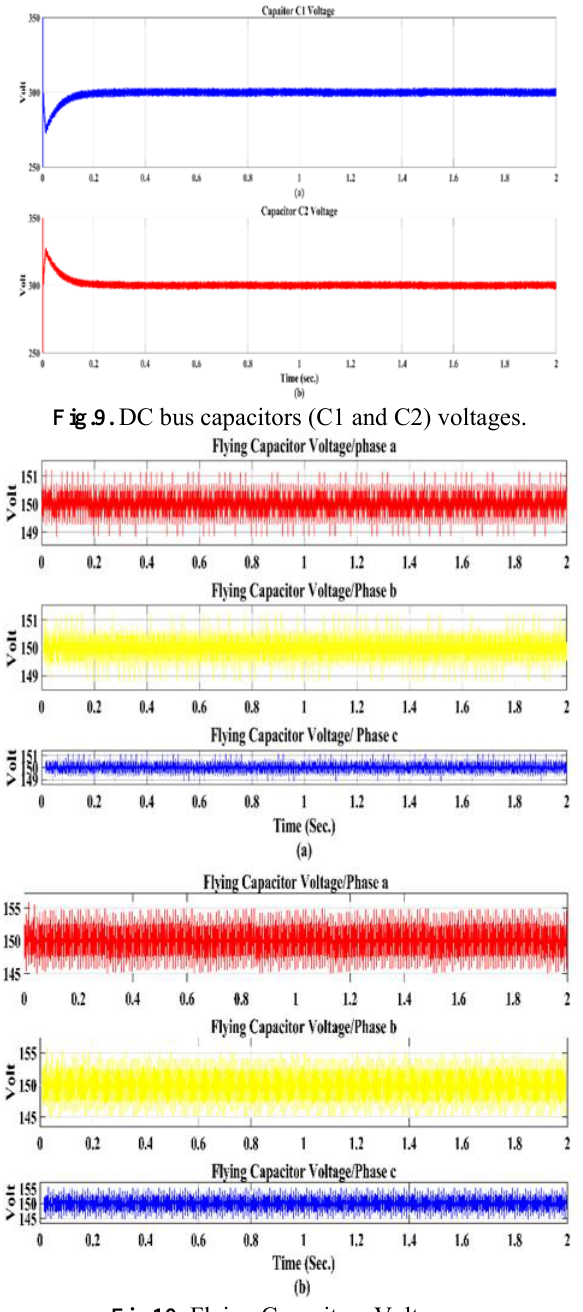
Fig.10. Flying Capacitors